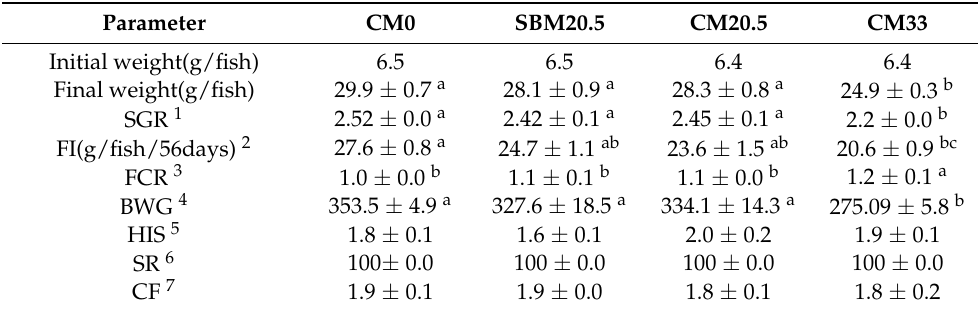
Table 5. Growth variables feed utilization markers, biometric indices, and survival obtained after 60 days feeding period in red seabream fed diets formulated by replacing fish meal with camelina meal at 0% for reference diet (CM0), 20.5 g/kg with soybean mean (SBM20.5), 20.5 g/kg with camelina meal (CM20.5) and 33 g/kg camelina meal